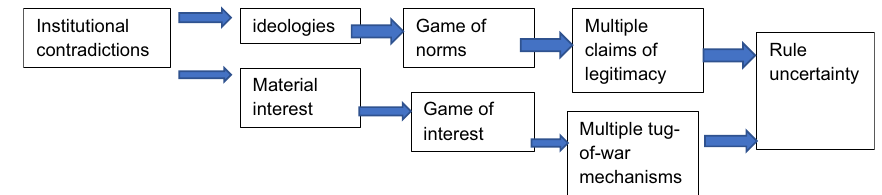
Fig. 3 Causes and mechanisms of rule